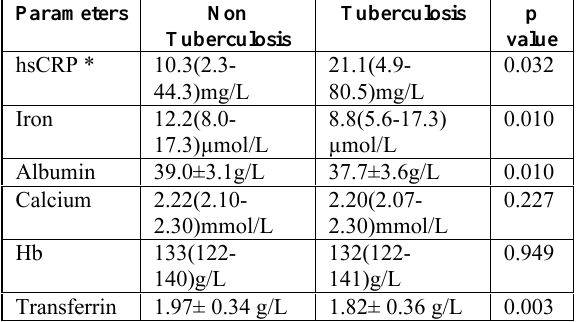
Table 2: Inflammatory and nutritional markers in two different COPD